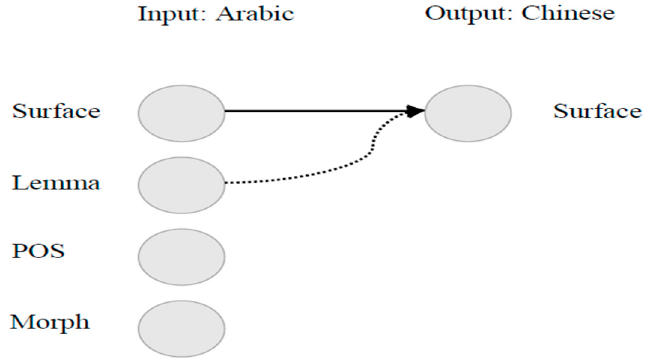
Figure 4. Lemma backoff model for the Arabic-Chinese factored MT.